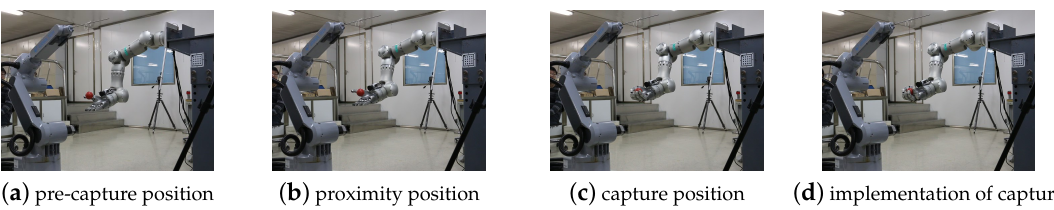
Figure 8. In the ground simulation experiment of the capture mission, each link is the same as that in the space experiment, in which the free speed of the pellet is strictly